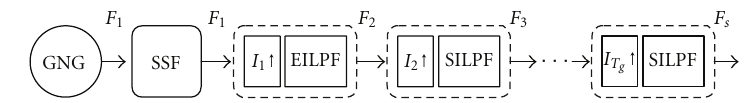
Figure 1: Block diagram of the fading simulator.